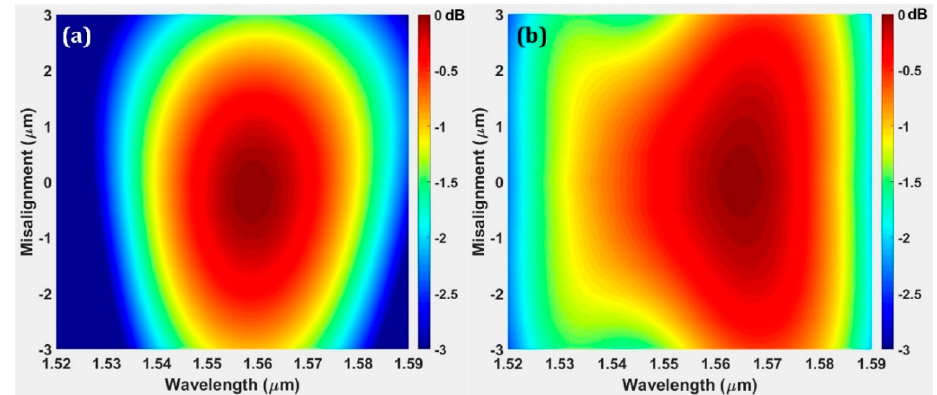
Figure 2. ( a ) The normalized optical power of different directions with perfectly vertical fiber incidence (inset picture shows the schematic of the BGC). ( b ) The wavelength-dependent grating split ratio with different fiber incident positions.